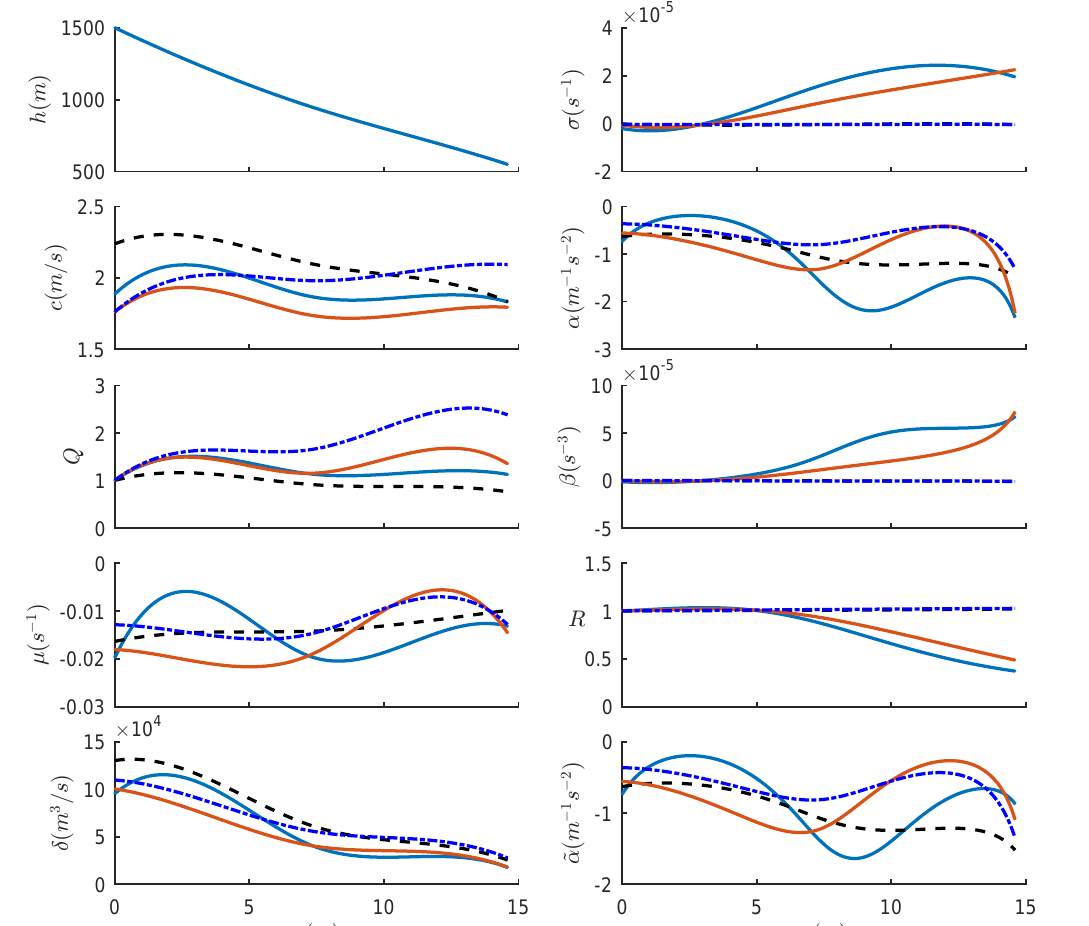
Figure 15. Variation of the original coefficients (left panel and top of the right panel) and derived coefficients (remainder of the right panel) of the vKdV equation for conditions of the Amazon River Mouth case. The results show the coefficients in summer with background current u 0 (blue, solid), without u 0 (black, dash) and the coefficients in winter with u 0 (red, solid), without u 0 (blue,